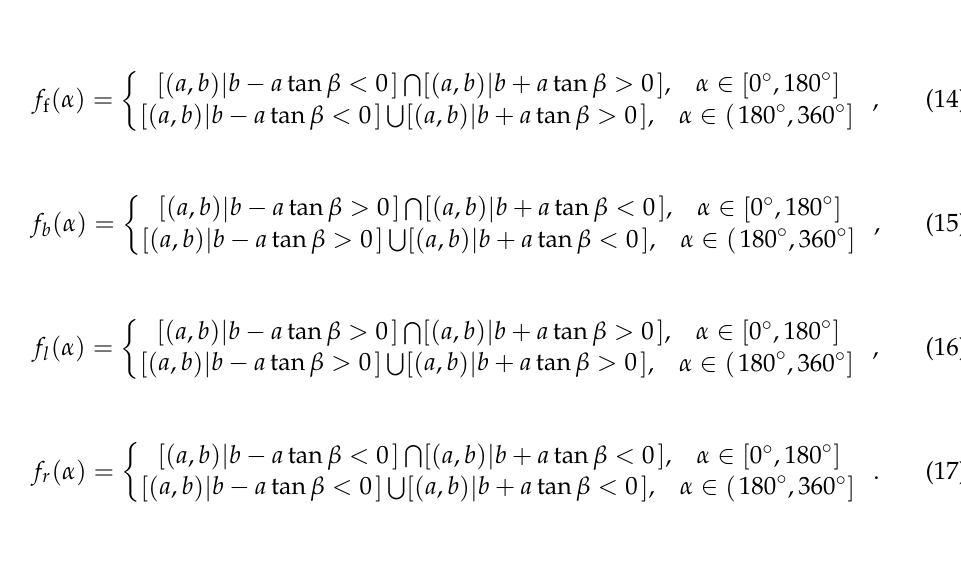
Figure 2. Simulation of different fields of view of